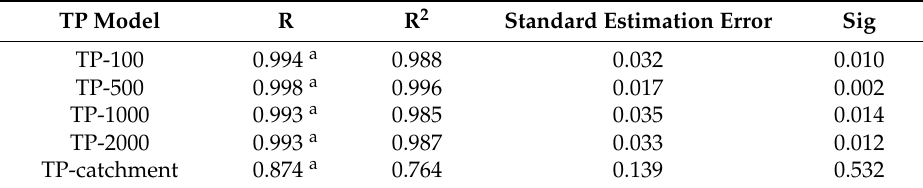
Table 10. The linear model general situation of TP.